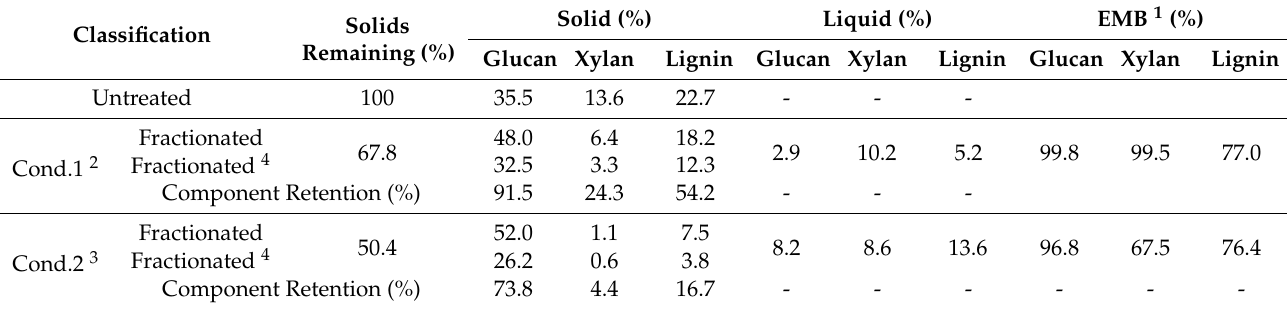
Table 5. Extraction mass balances of glucan, xylan, and lignin following the process of organosolv fractionation from rice husks under optimal